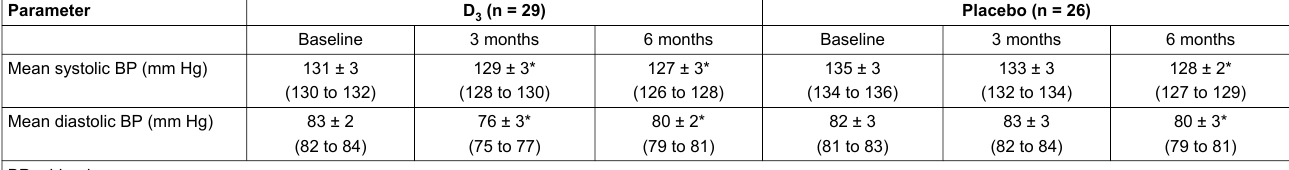
Table 7: Effect of vitamin D (D3) supplementation on 24 hour ambulatory blood pressure (mean ± standard deviation, 95% confidence interval).